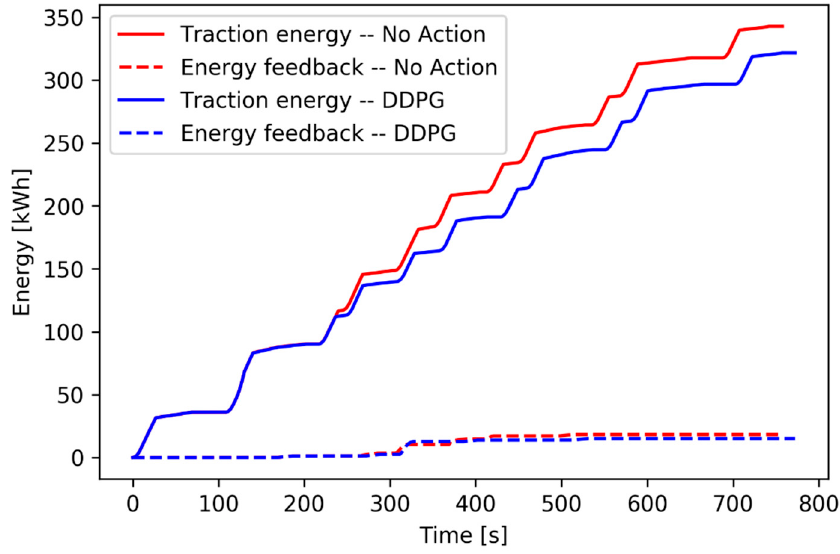
Figure 12. Energy accumulation under a 10.76 s delay in the two-train network.